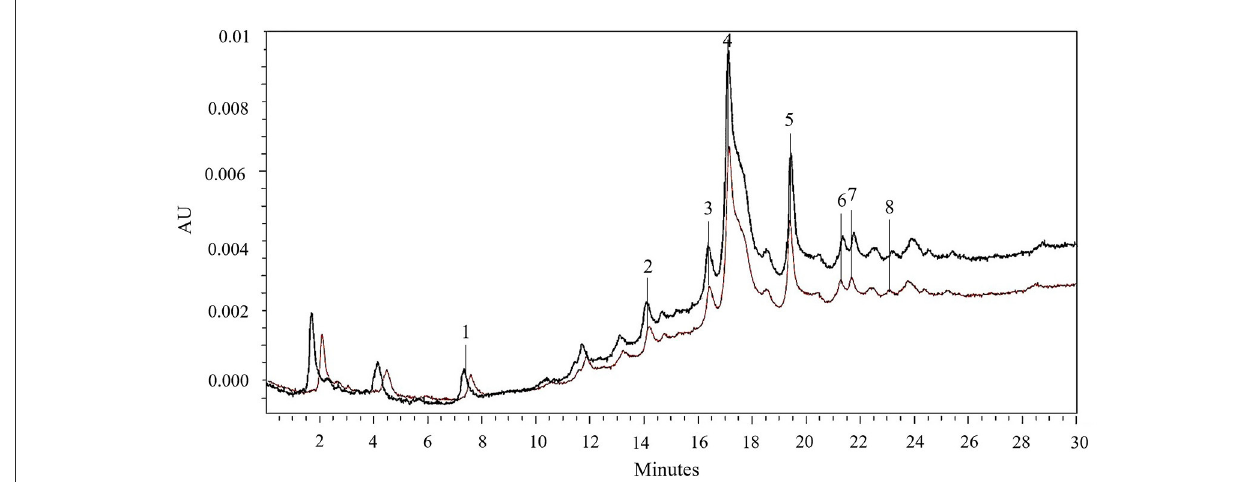
FIGURE7 HPLC-PDA chromatograms of 50% (v/v) ethanol-water extracts obtained after 300min of extraction at 50 ◦ C from untreated (brown line) and PEF (E opt = 4.6 kV/cm; W T,opt = 20kJ/kg)-treated (black line) red grape pomace. Peak identification: gallic acid (1); chlorogenic acid (2); caffeic acid (3); epicatechin (4); p-coumaric acid (5); naringin (6); rutin (7); phlorizin (8).